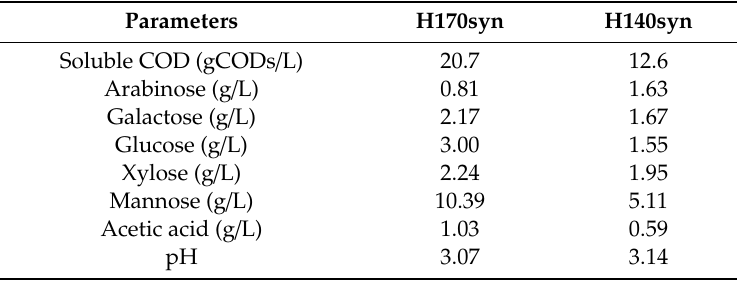
Table 2. Content of synthetic